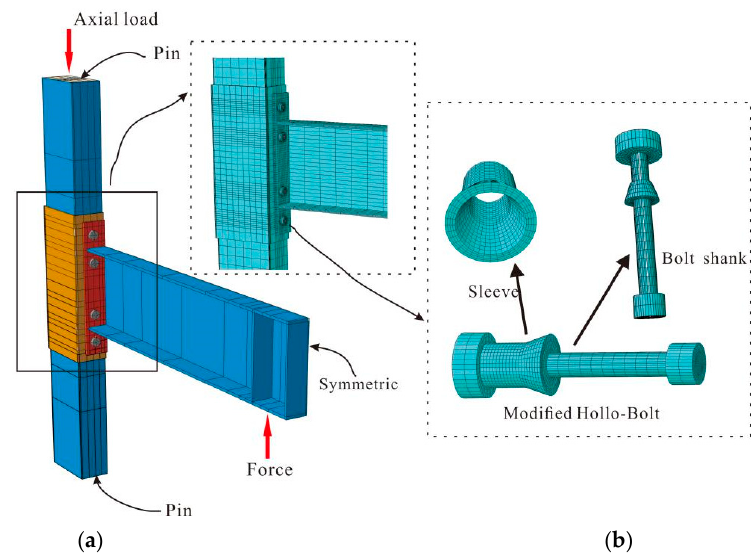
Figure 23. Model assembly and mesh of the components. ( a ) Global mesh of the joints; ( b ) Mesh of the bolt and the sleeve.